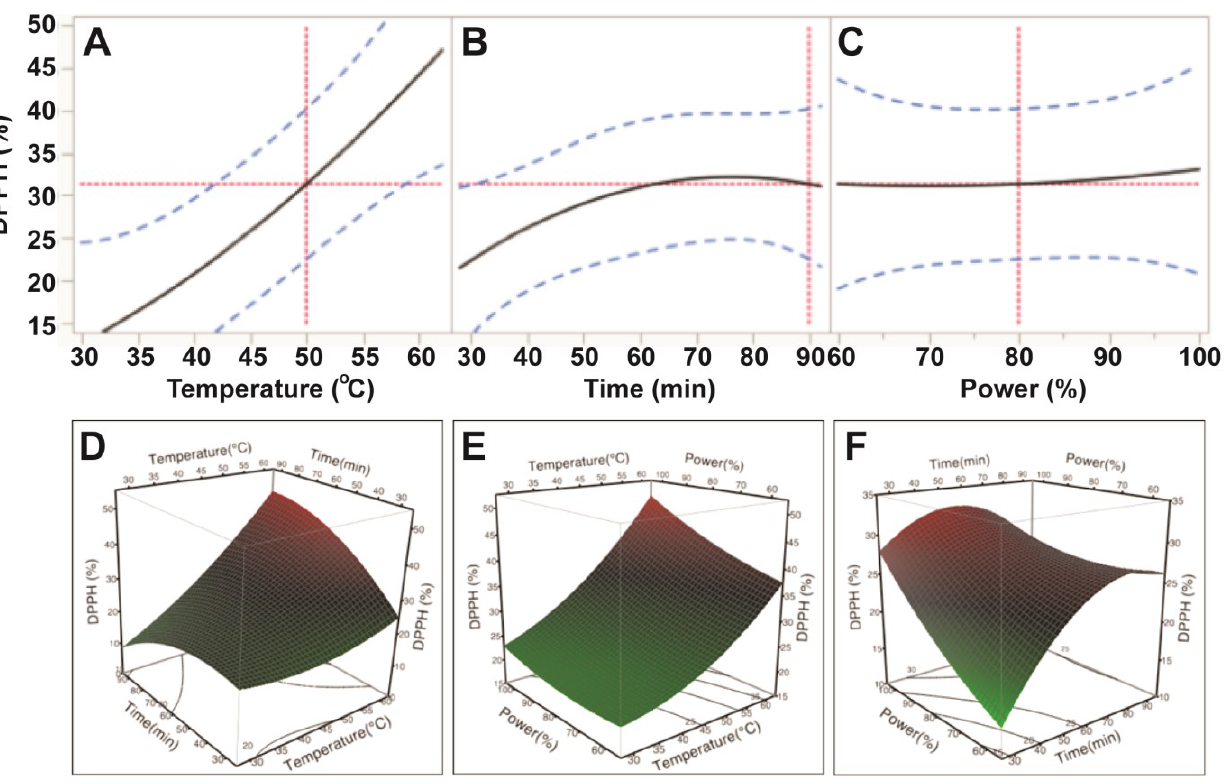
Figure 4. Impact of ultrasonic temperature (30–50 °C), time (30–90 min) and